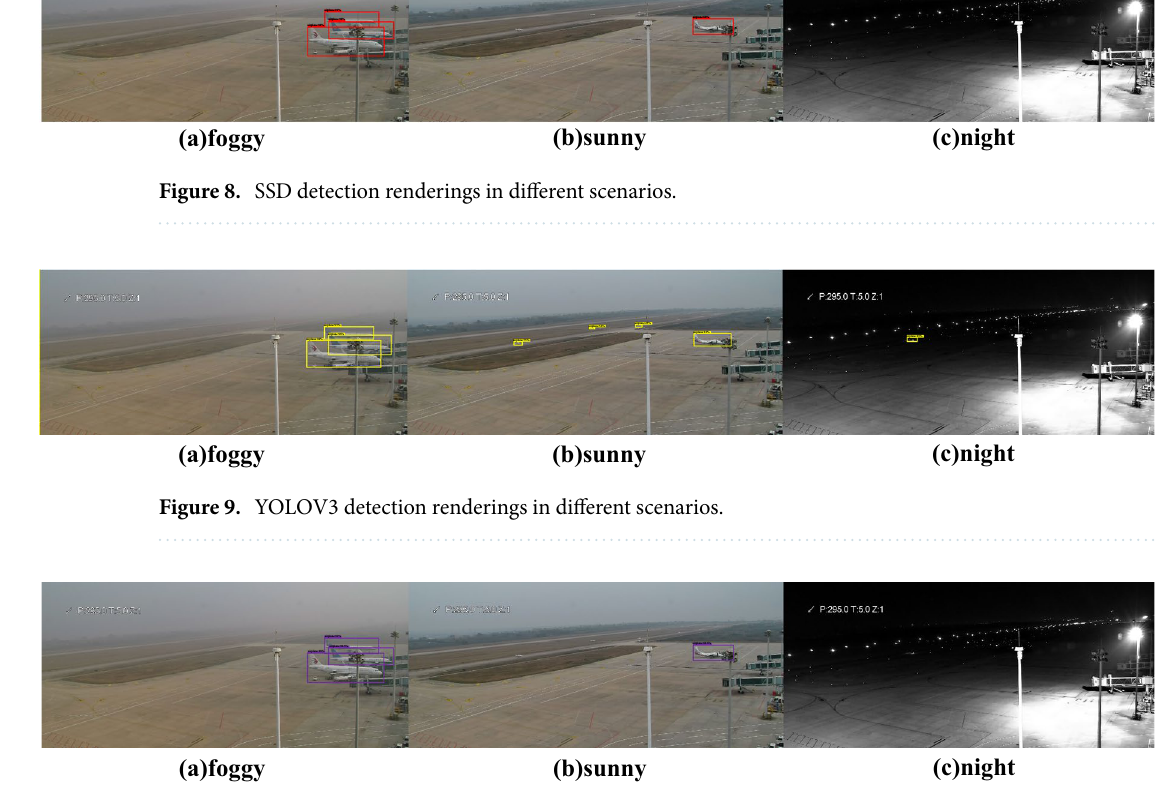
YOLOX-Nano for small target detection, but some small targets have missed detection. RPD detects the most significant number of small targets and two more targets than YOLOV3 because our position loss function intro- duces GIou Loss. Simultaneously, the adjacent scale feature fusion technology is used to fuse the deep semantic information into the shallow features layer by layer, improving the detection accuracy of small objects. It can be found in part (c) that Faster-RCNN, SSD, YOLOX-Tiny and YOLOX-Nano can not recognize the aircraft in the